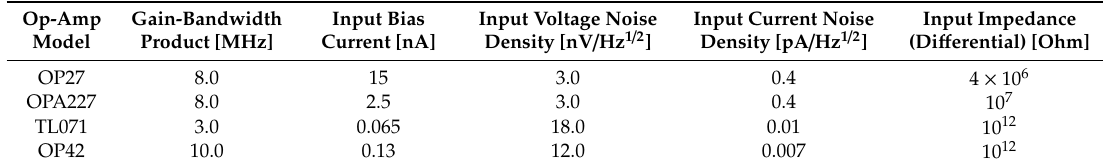
Table 1. Selected parameters of the op-amps used in the measurements [7–10].